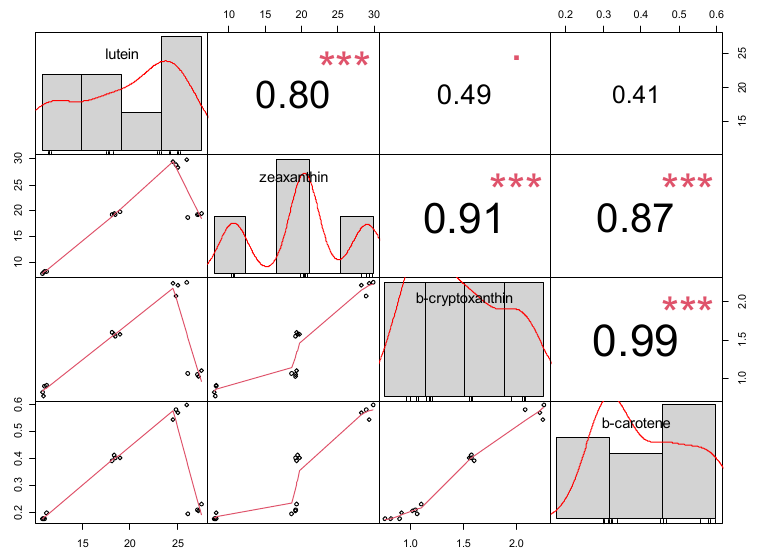
Figure 6. Correlation matrix of yield per hectare of lutein, zeaxanthin, β -cryptoxanthin, β -carothene (mg kg − 1 × yield t ha − 1 ). Note: *** ( p <